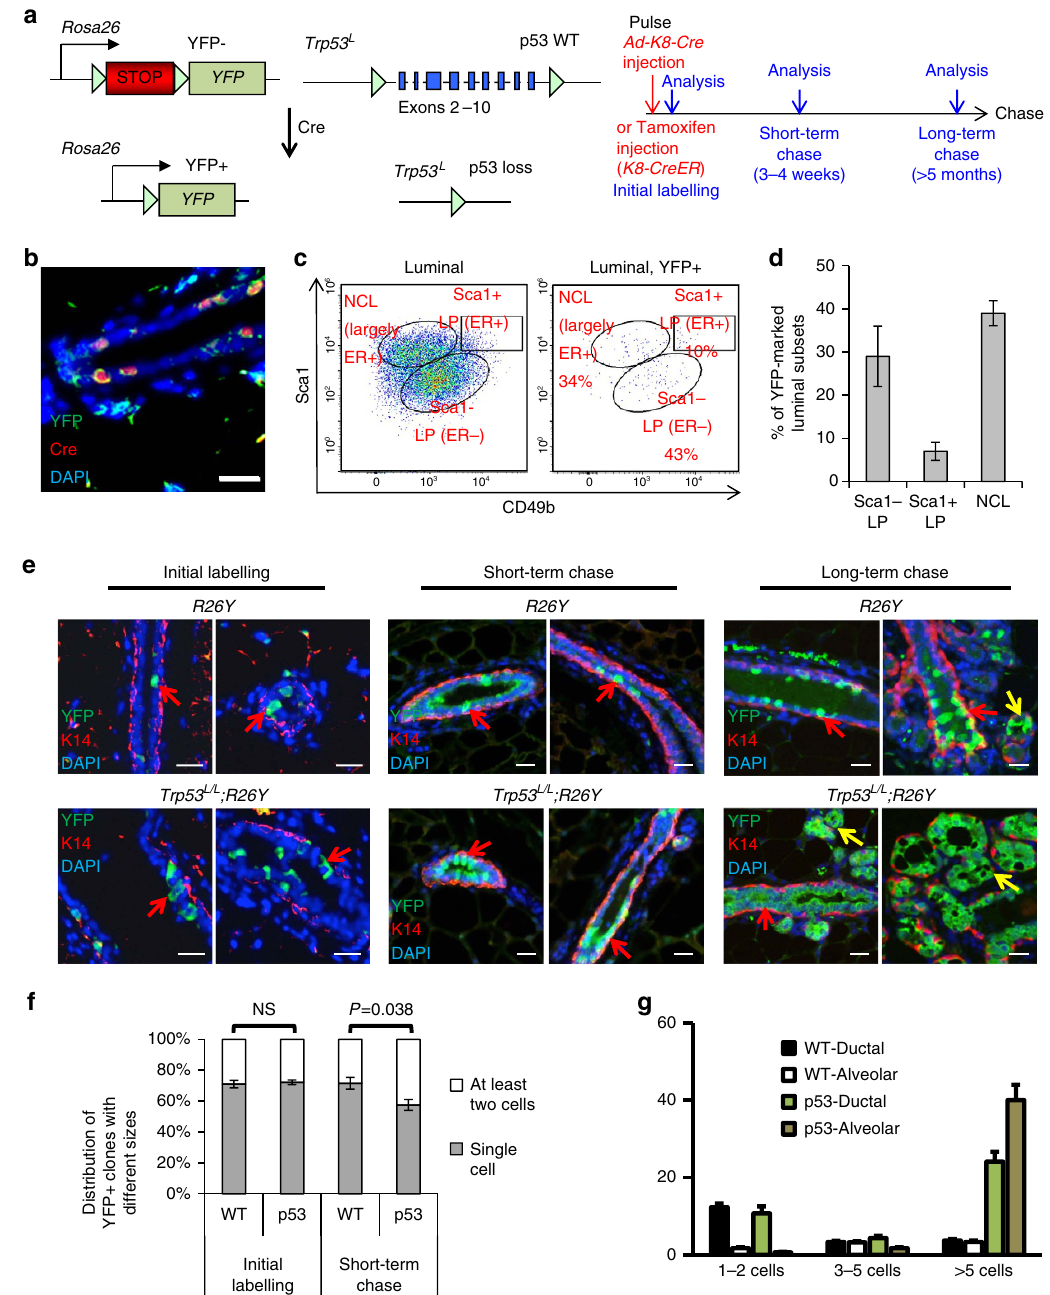
Figure 1 | Induced loss of p53 in luminal cells leads to their clonal expansion. ( a ) Schematic diagrams of lineage tracing: Cre (either from transient expression from intradcutally injected Ad-K8-Cre or upon tamoxifen-induced activation of K8-CreER )-mediated excision of either a floxed transcriptional Stopper cassette (STOP) in the R26Y reporter, or floxed exons 2–10 in the Trp53 L allele, leads to YFP expression and disruption of Trp53 simultaneously (Pulse). The induced females were analysed on chasing for various time periods. ( b ) Representative co-IF picture showing YFP (green) and Cre (red) staining on a MG section from a Trp53 L/L ;R26Y female 3 days after Ad-K8-Cre injection. Trp53 L/L ;R26Y females ( n ¼ 3); R26Y females ( n ¼ 3). Scale bar, 20 m m. ( c ) FACS analysis showing YFP-marked NCL cells, Sca1 þ ER þ LPs and Sca1 (cid:2) ER (cid:2) LPs, 3 days after injection of Ad-K8-Cre to R26Y MGs. ( d ) Quantification for the three luminal subpopulations shown in c ( n ¼ 3). ( e ) Co-IF staining showing presence of YFP-marked MECs (green cells, red arrows) 3 days after Ad-K8-Cre injection (representing the initial labelling pattern, left), or on either a short-term (middle) or long-term chase (right). Staining for the basal marker Keratin 14 (K14) was used to indicate basal MECs (red cells). On a long-term chase, examples of extensive expansion of YFP þ Trp53 -null ductal luminal cells (lower right panels, red arrow) and alveolar luminal cells (lower right panels, yellow arrows) were shown; corresponding YFP-marked ductal (upper right panels, red arrows) and alveolar (upper right panels, yellow arrow) luminal cells from WTcontrol mice were also shown. Scale bars, 20 m m. ( f ) Quantification of percentages of YFP-marked single-cell and multi-cell clones in MGs of Trp53 L/L ;R26Y (p53) or R26Y -only females (WT) as shown in e (initial labelling: n ¼ 4 for WT, n ¼ 3 for p53; short-term chase: n ¼ 7 for WT, n ¼ 4 for p53). P value: NS, not significant, two-tailed Student’s t -test. ( g ) Quantification of the numbers and types of YFP-marked clones in MGs of the injected Trp53 L/L ;R26Y (p53, n ¼ 5) or R26Y -only females (WT, n ¼ 4) after long-term chase, as shown in e . In both f , g at least 10 ducts per section were counted. Data represent mean ± s.e.m. NATURE COMMUNICATIONS|8:14431|DOI: